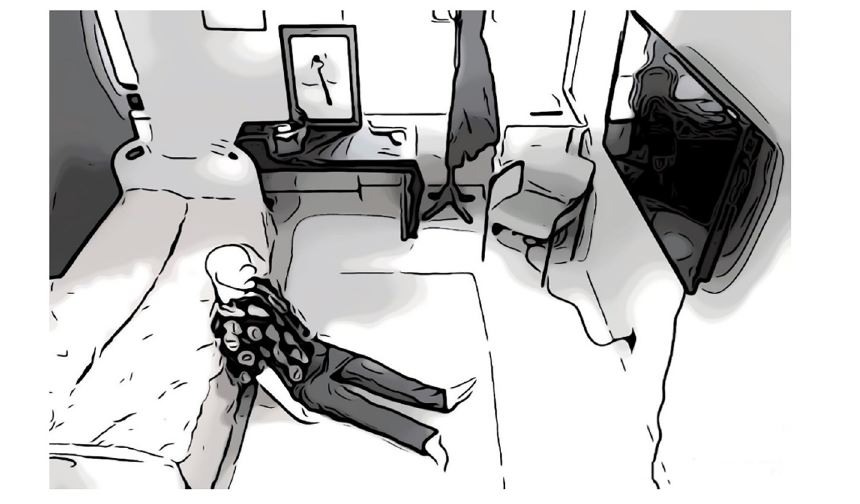
Fig 1. Schematic of the simulation